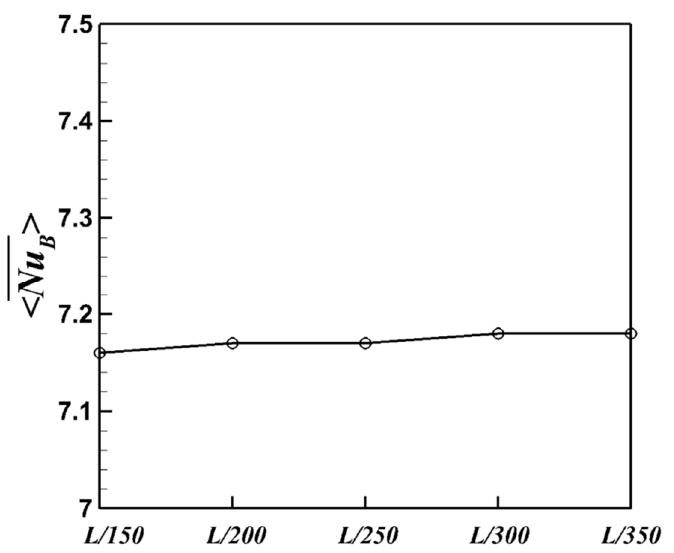
Figure 2. Time- and surface-averaged Nusselt number on bottom wall for different grid sizes at Re = 1000 and Gr = 10 5 .